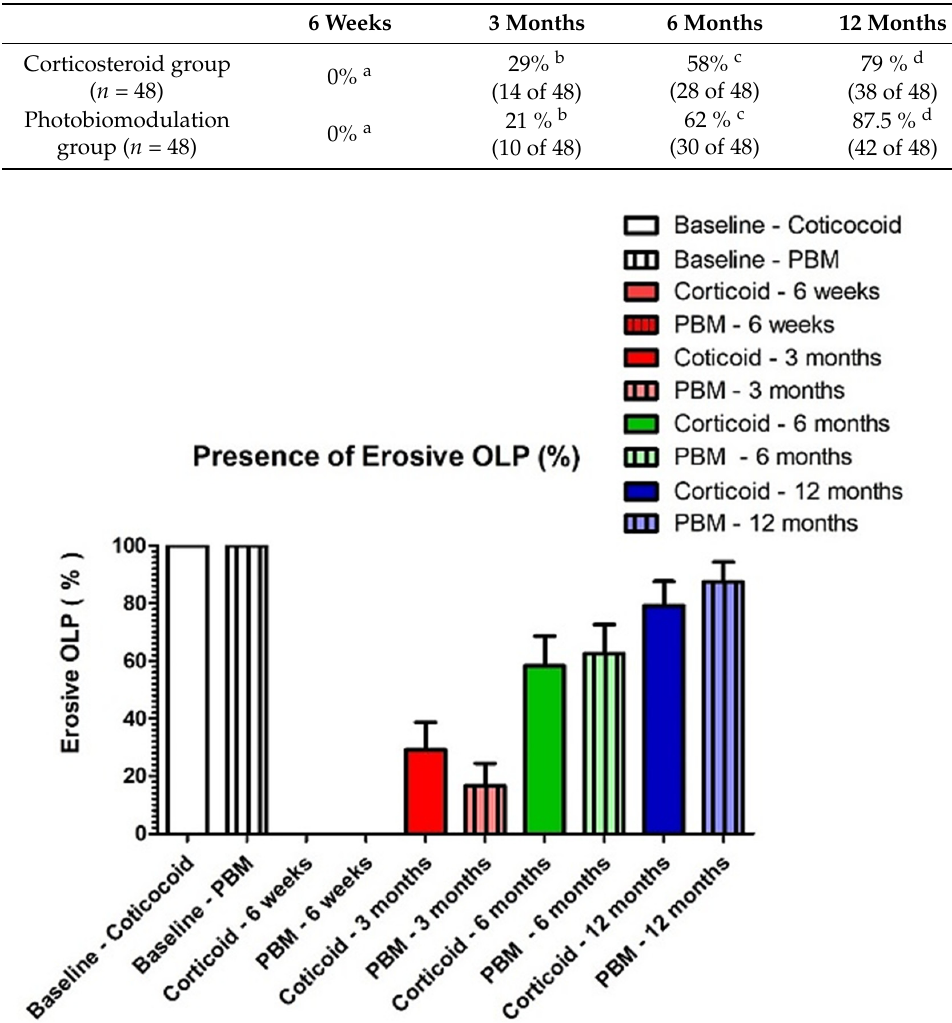
Figure 3. Aspect of the OLP at 6 weeks of PBM treatment. The erosive area and pain have disappeared. A slight reduction in the size of the lesion may be noted. Table 5. Recurrence rate of erosive & painful OLP at different periods of follow-up. Similar letters indicates non-significant differences. Different letters indicate significant differences.